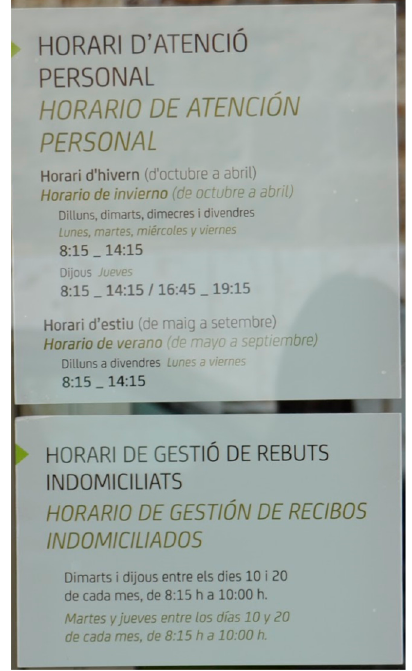
Figure 28. Benasal: Bilingual sign on a bank office .